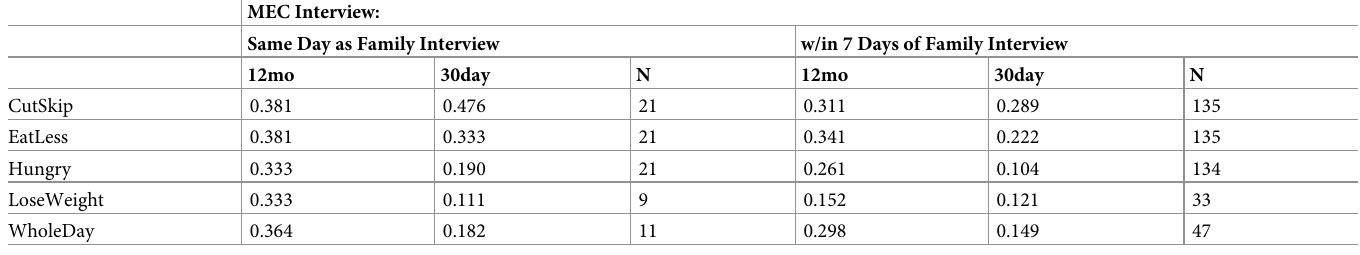
Table 5. Prevalence of individual 30-Day and household 12-month food hardships at the end of SNAP month among households interviewed in the final 6 days of the SNAP month. MEC